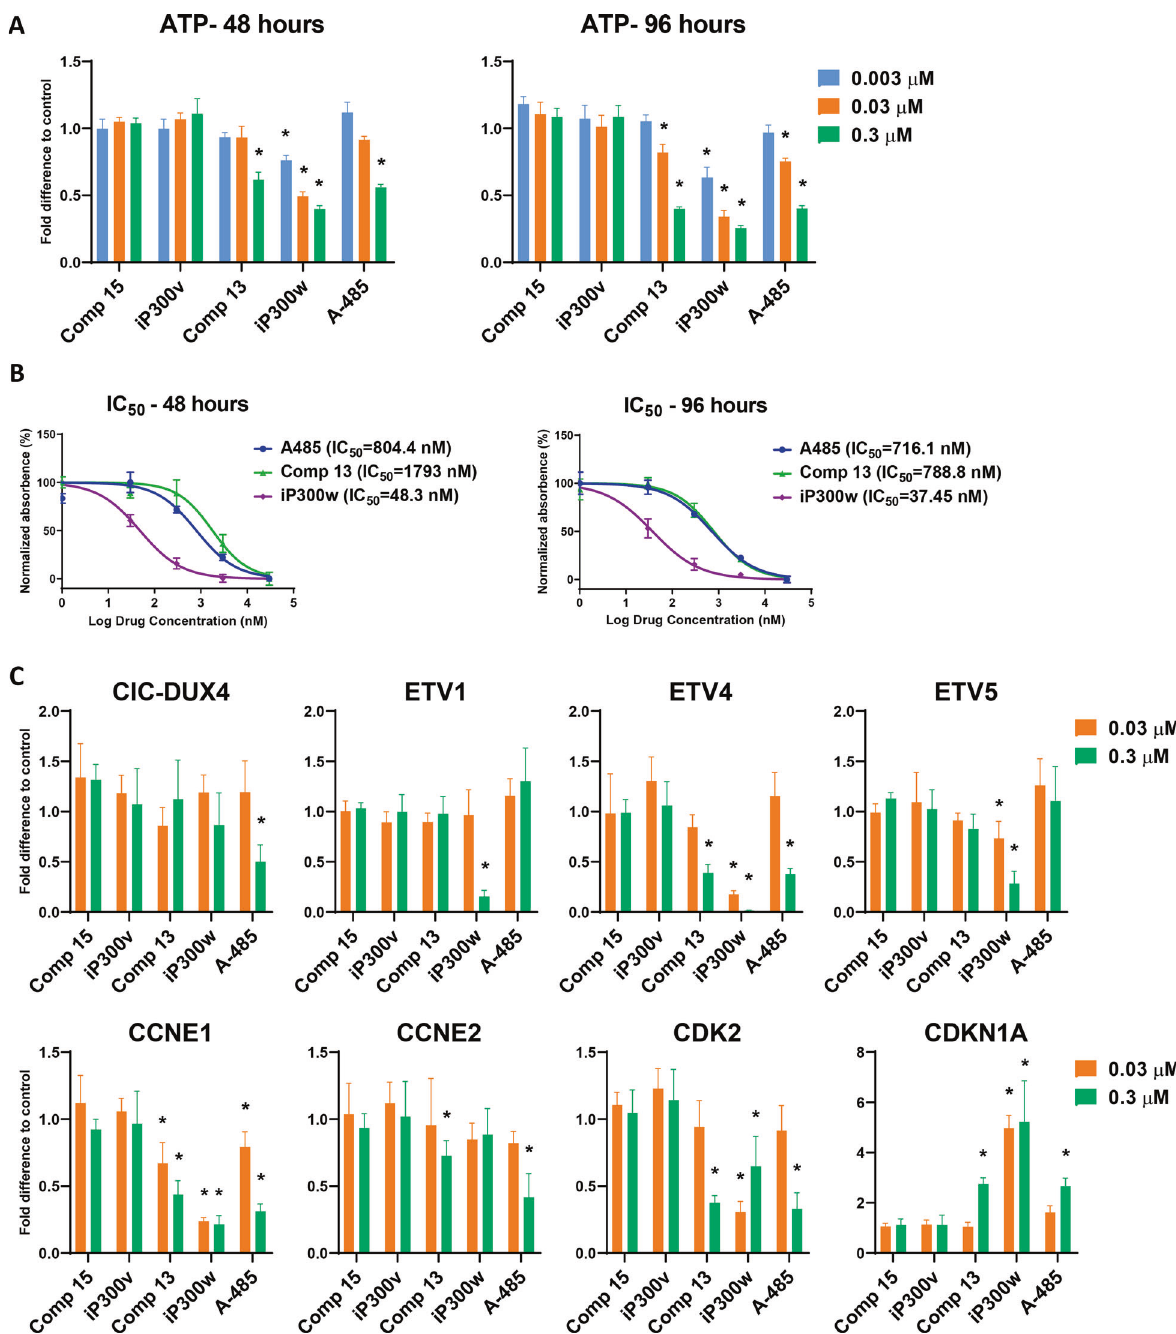
Fig. 3 Effect of iP300w stereoisomers on CIC-DUX4 sarcoma cell line viability. A ATP viability assays at 48 and 96 h of treatment of NCC- CDS-X1 cells with different concentrations of iP300w stereoisomers and A-485. B IC 50 values of A-485, Comp 13 and iP300w in NCC-CDS-X1 cells at 48 and 98 h of treatment. C RT-qPCR for CIC-DUX4 target genes in NCC-CDS-X1 cells after 24 h treatment with 0.03 and 0.3 µM iP300w stereoisomers and A-485. Data is presented as mean ± SEM; * p < 0.05, by two-way ANOVA. Results are presented as expression relative to control ( n =